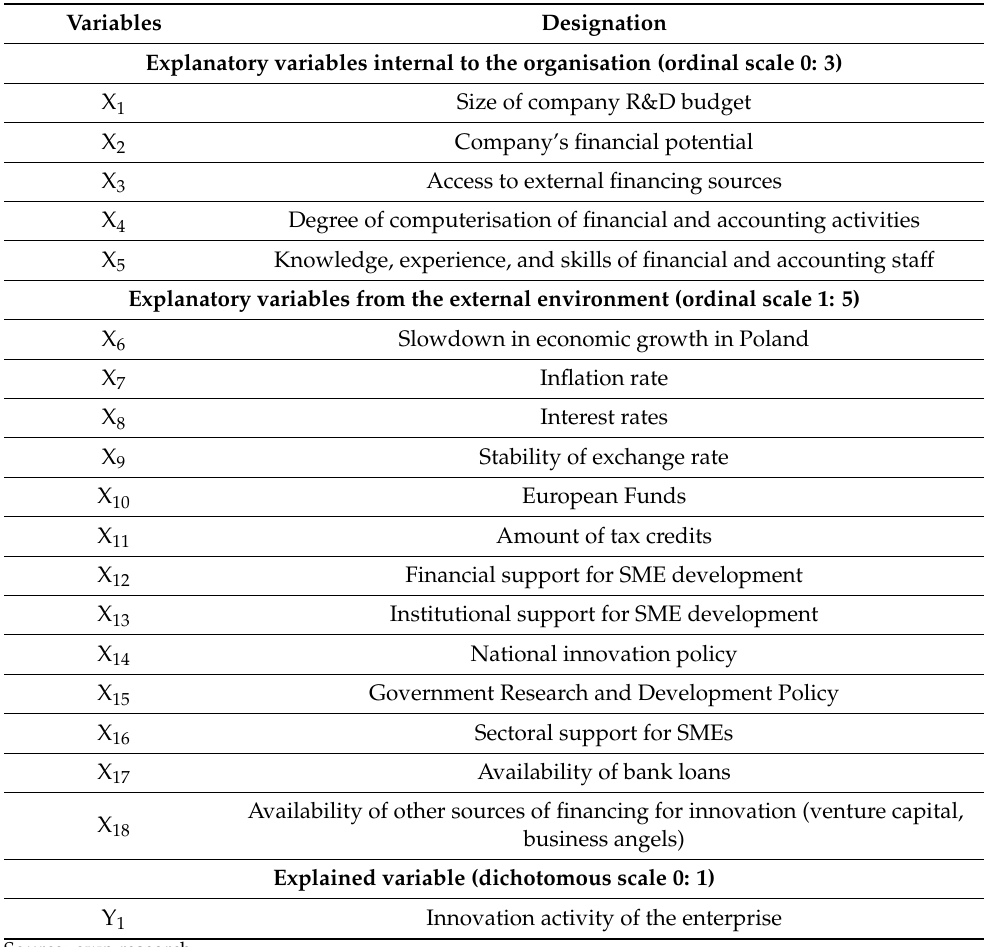
Table 2. Characteristics of variables used in the financial